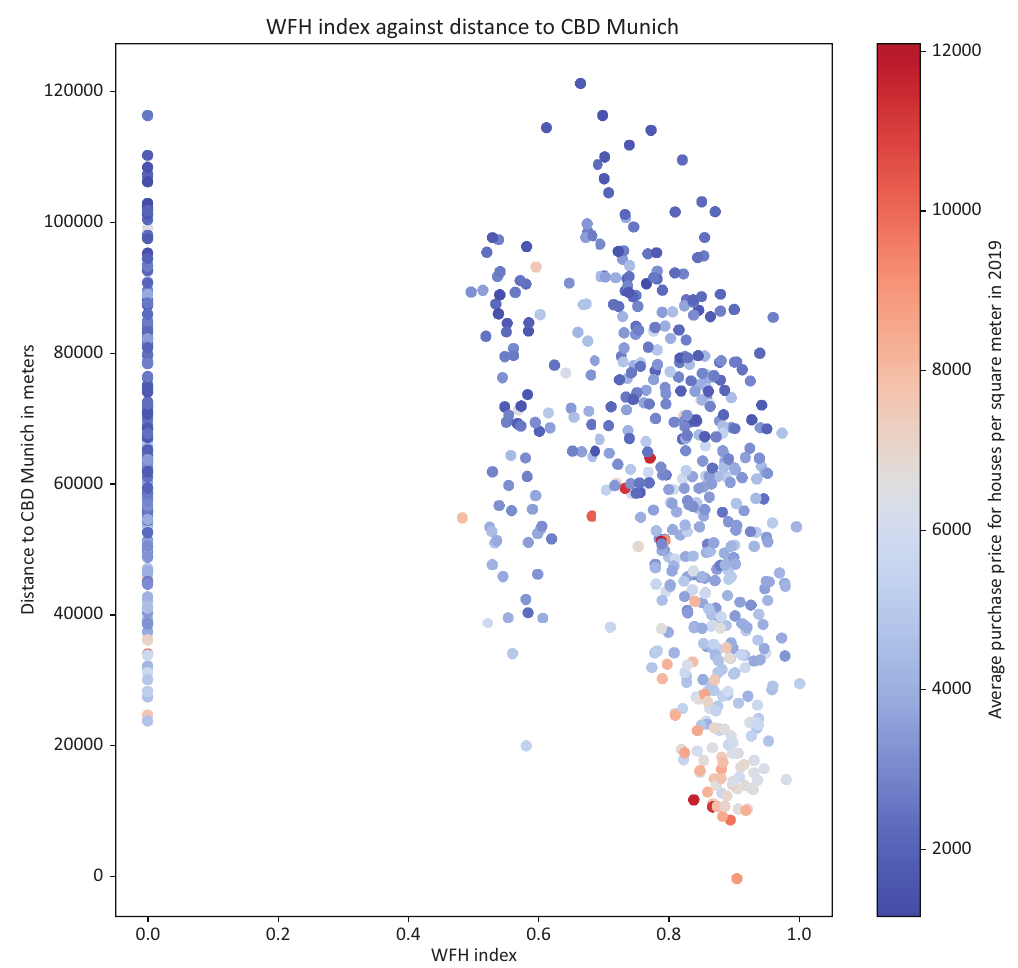
Figure 5. WFH index against distance to CBD